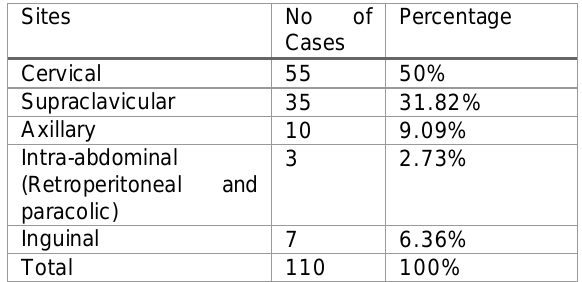
Table No: 2 Distribution of Metastatic Lesions at variuos sites.